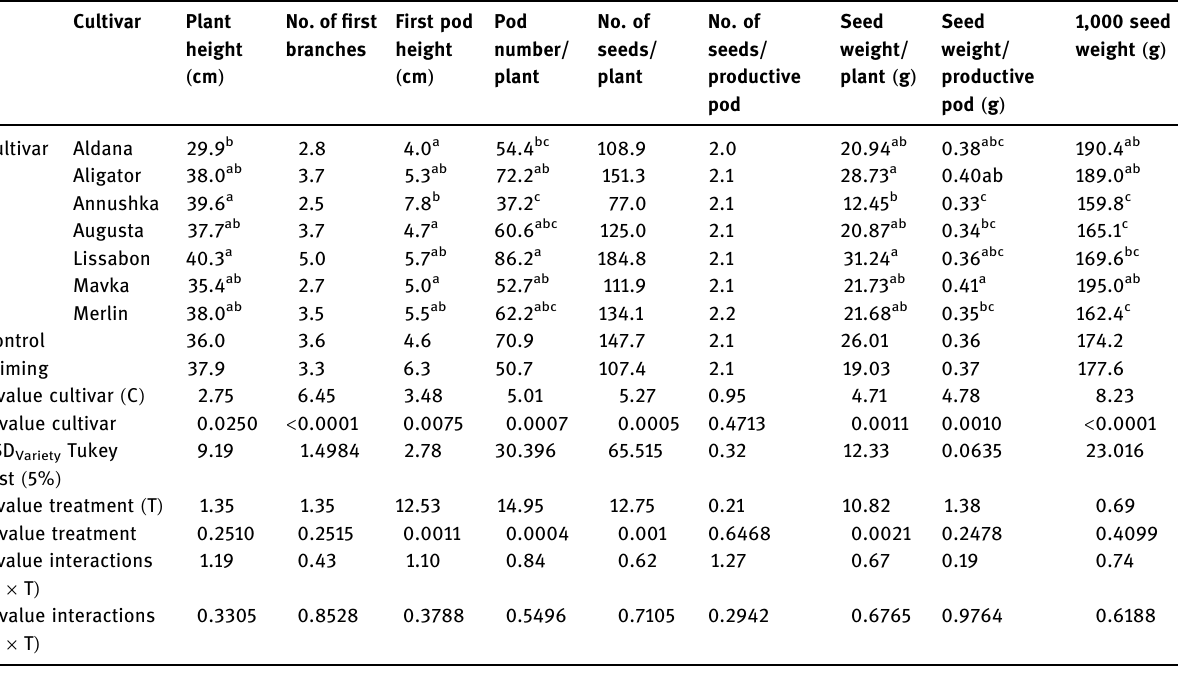
Table 4: E ff ect of seed priming and soybean variety on morphological and yield - related traits. Superscripts represent signi fi cance groups Cultivar Plant